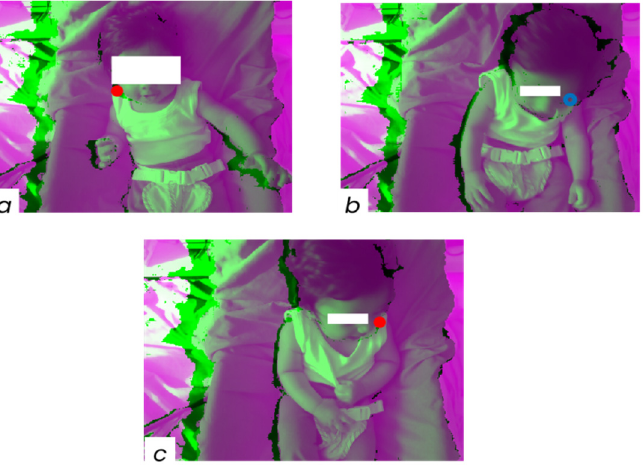
Figure 2. Issues causing undefined 3D PoI positions: ( a ) RS falling on the “black area”, ( b ) occlusion of the LS from the head, and ( c ) residual spatial misalignment between RGB and depth images. Subjects are made unidentifiable by using white patches. The coloured circles represent PoIs.